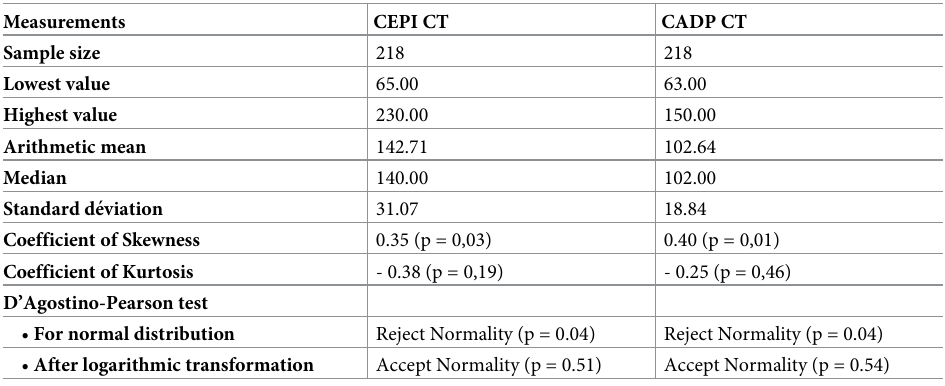
Table 2. Statistical analysis of CEPI CT and CADP CT PFA-100.